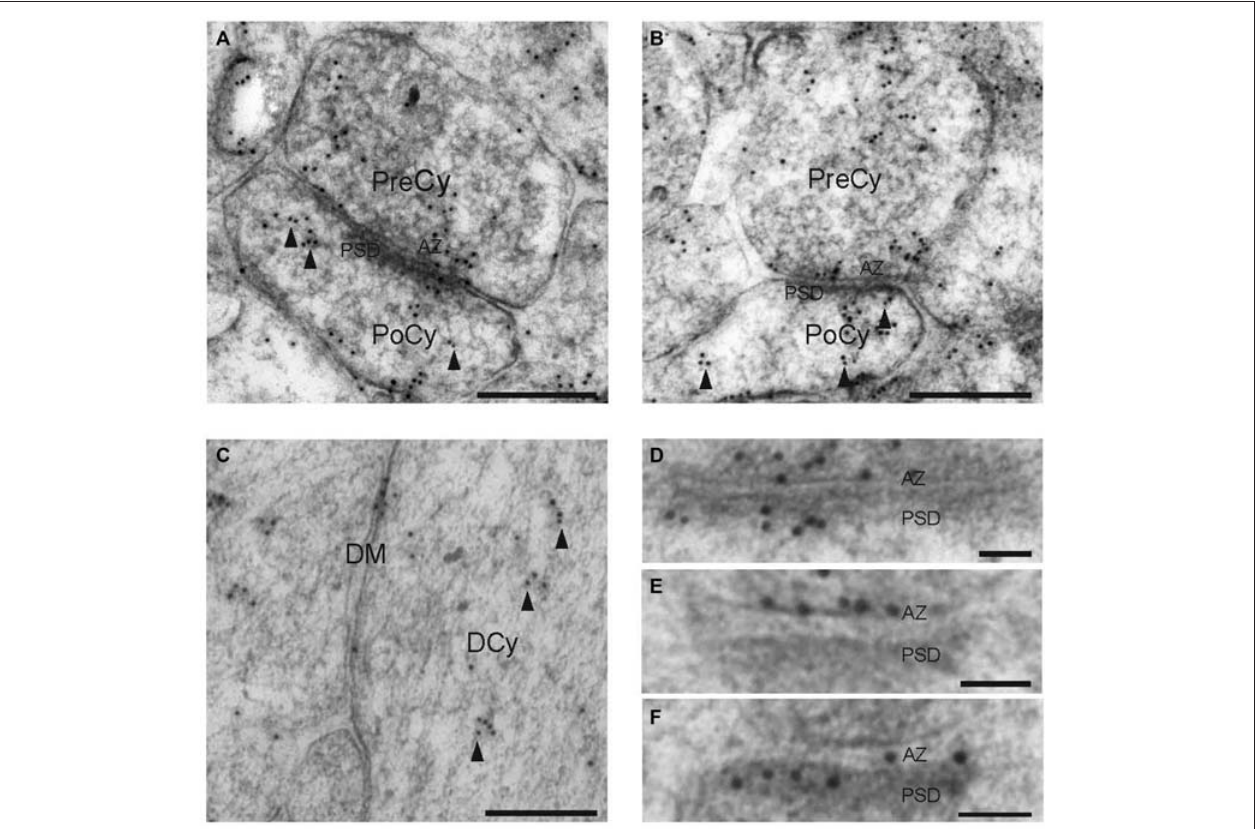
FIGURE 3 | Electron micrographs showing syntaxin-1 immunogold labeling of the synapses and dendrites in the CA1 region of the rat hippocampus. (A,B) Gold particles are present over pre- and post-synaptic vesicles, as well as synaptic plasma membranes. (C) Immunogold labeling of syntaxin-1 in dendrite. (D–F) Gold particles located over active zone and post synaptic densities. Scale bars: (A,B) 250 nm. (C) 200 nm. (D − F) 50